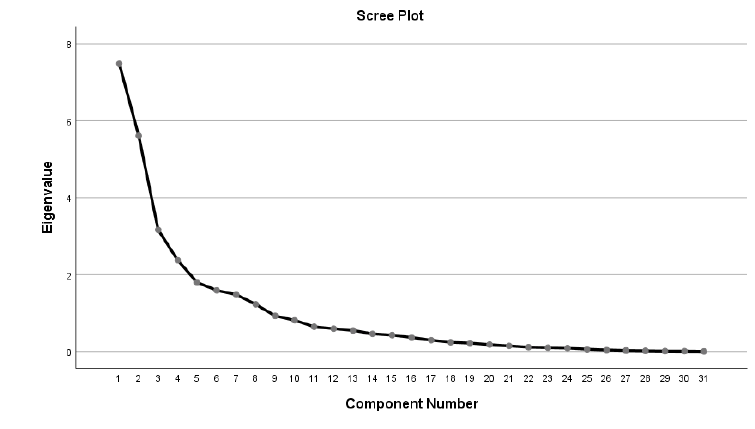
Fig. 2. The results of Scree